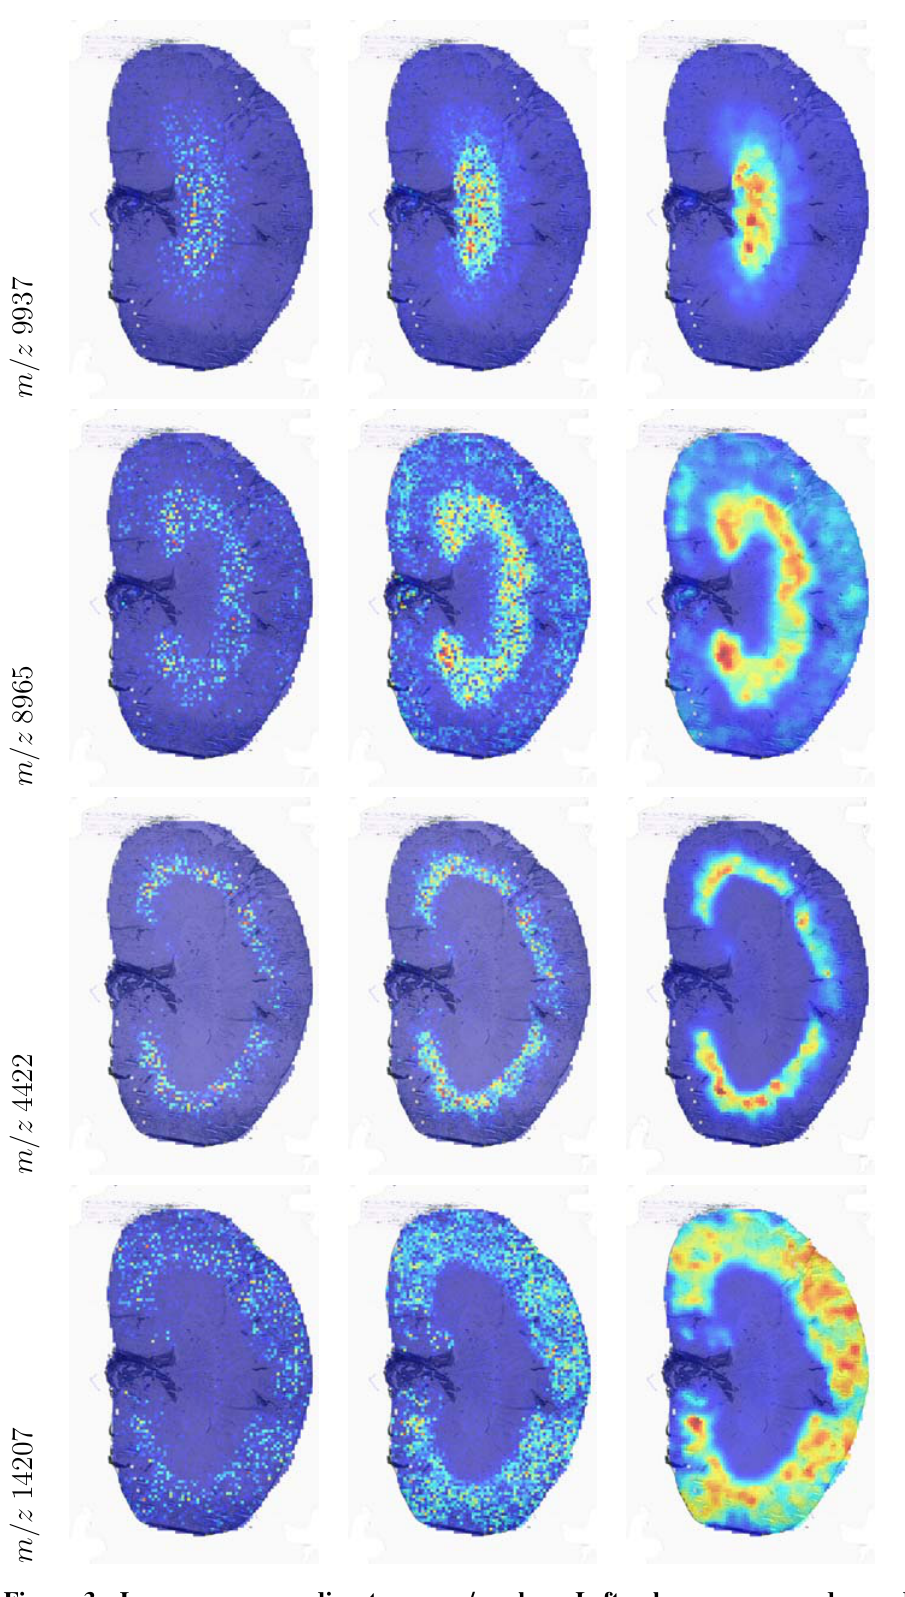
Figure 3: Images corresponding to one m/z-value. Left column: measured raw data, middle column: after TIC normalization and baseline correction, right column: after edge-preserving denoising. a.u. = arbitrary